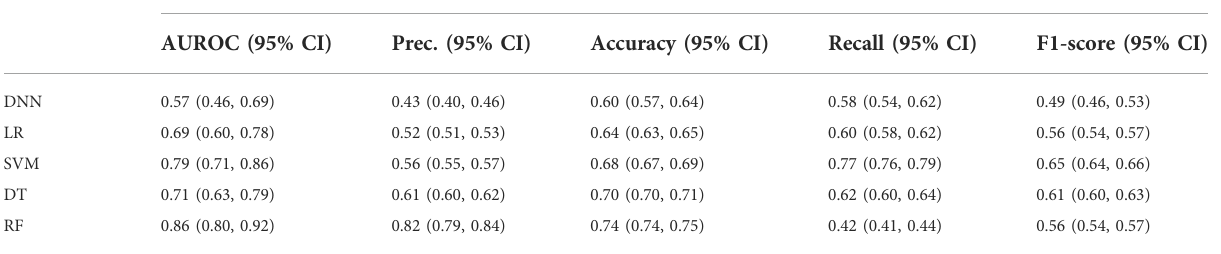
TABLE 2 Discrimination tests of fi ve machine learning models for predicting